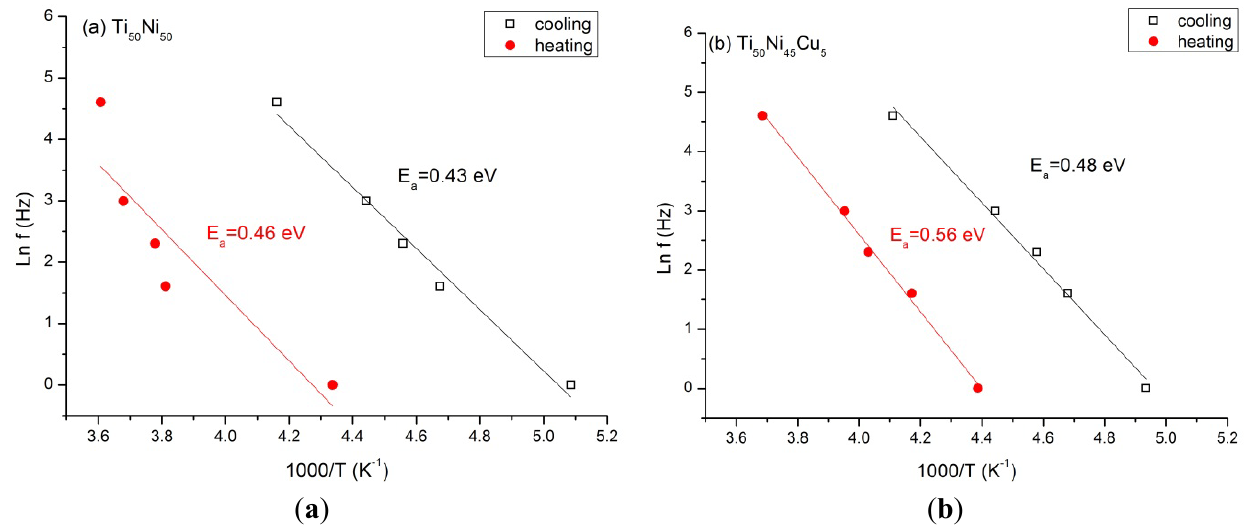
Figure 6. The plots of ln frequency vs . reciprocal relaxation peak temperature in cooling